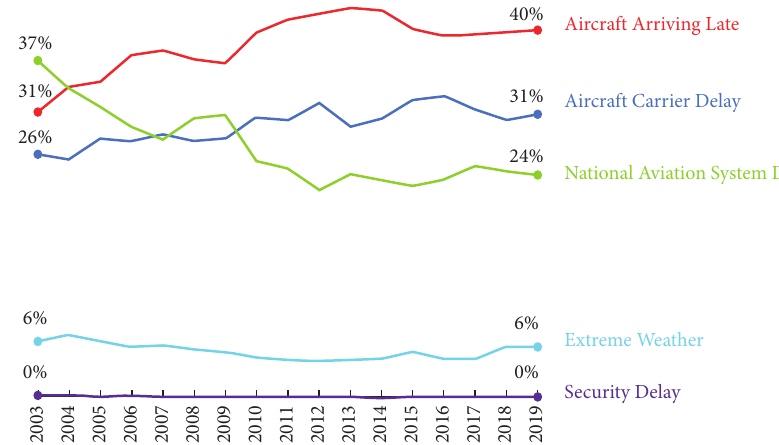
Figure 2: Delay cause by year, as a percent of total delay